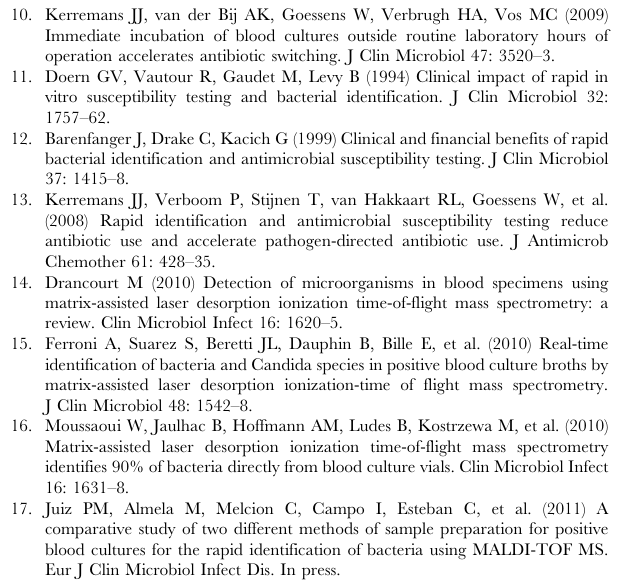
Table S1 Number of microorganisms identified from episodes of positive blood cultures throughout the study period.